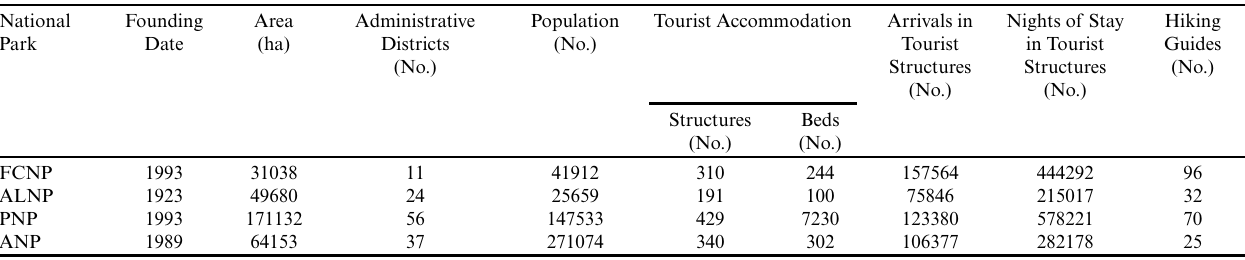
Table 1 . Overview of statistics for the four national parks (NP) involved in the study (data from ISPRA 2018). Parks are listed going from north to south along the Apennine range. Data regarding tourist arrivals, nights of stay, and accommodation are reported at a district level, which in many cases includes areas outside the park boundaries, potentially determining an overestimation of visitors. However, data do not include visitors on a one-day trip, who do not use accommodation structures within the park area. This pool of visitors may represent a high percentage of the total tourists visiting NPs in Italy annually, but the actual number is not available because access is not officially checked, and entrance is free. NOTE: FNCP = Foreste Casentinesi, Monte Falterona e Campigna National Park, ALNP = Abruzzo, Lazio e Molise National Park, PNP = Pollino National Park, and ANP = Aspromonte National